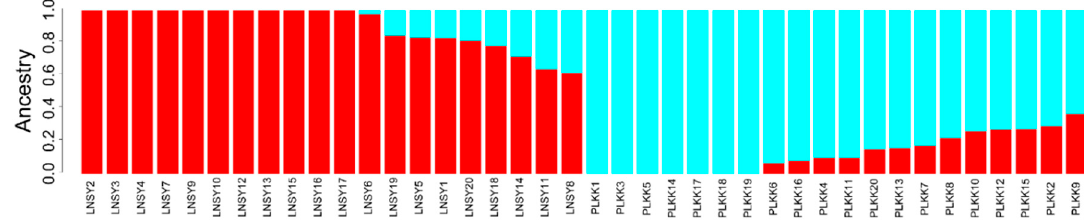
Figure 2. Admixture for LNSY and PLKK populations of H. axyridis (K = 2). Each bar represents an individual from each of the collection locations (X axis). Individual admixture coefficients are represented in each column (Y axis).